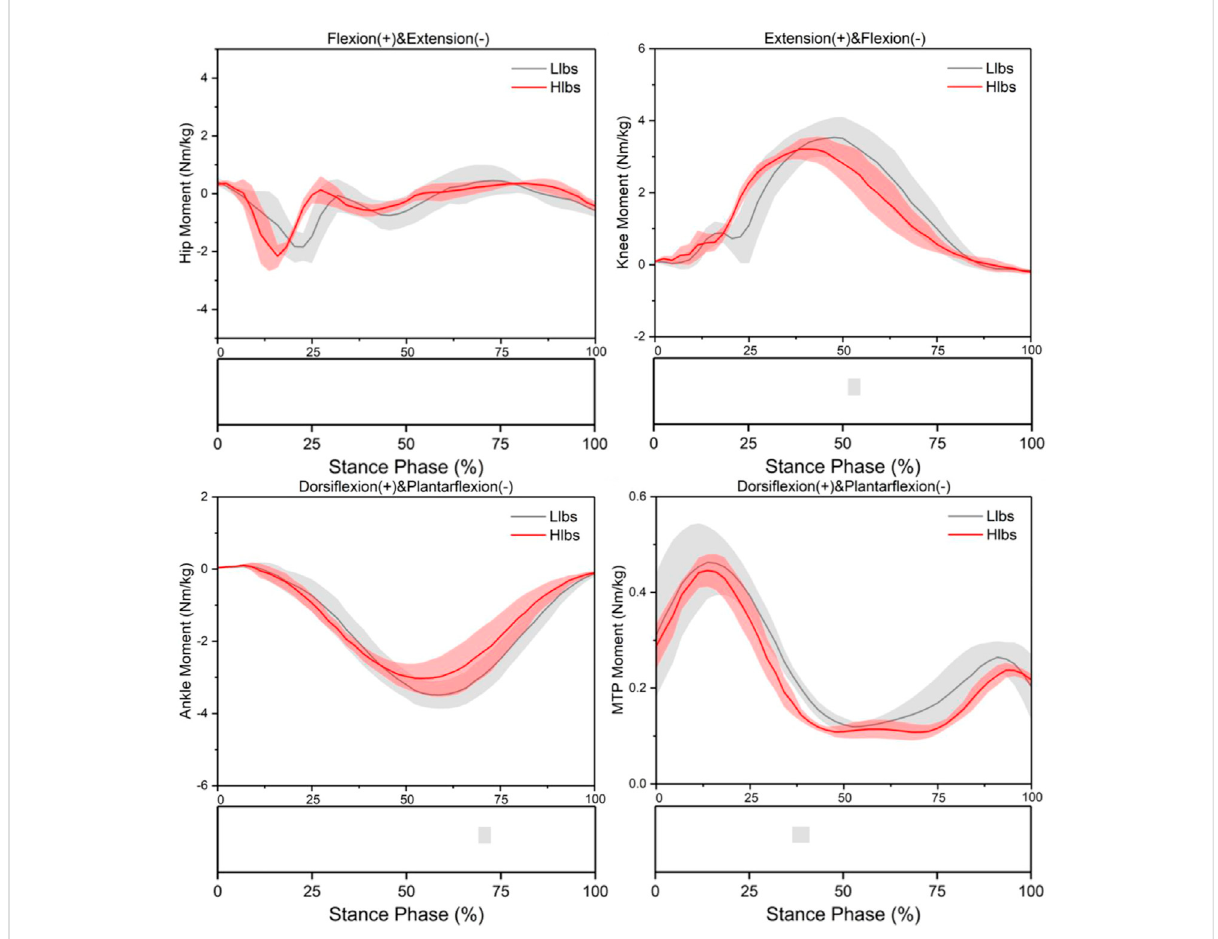
FIGURE 3 Lower limbjointmoment waveformsof meanand standard deviation overthestancephaseof twoshoe conditions. Signi fi cantdifferences ( p < 0.05) are highlighted (grey horizontal bars at the bottom of the fi gure) during corresponding periods from SPM1d analyses.